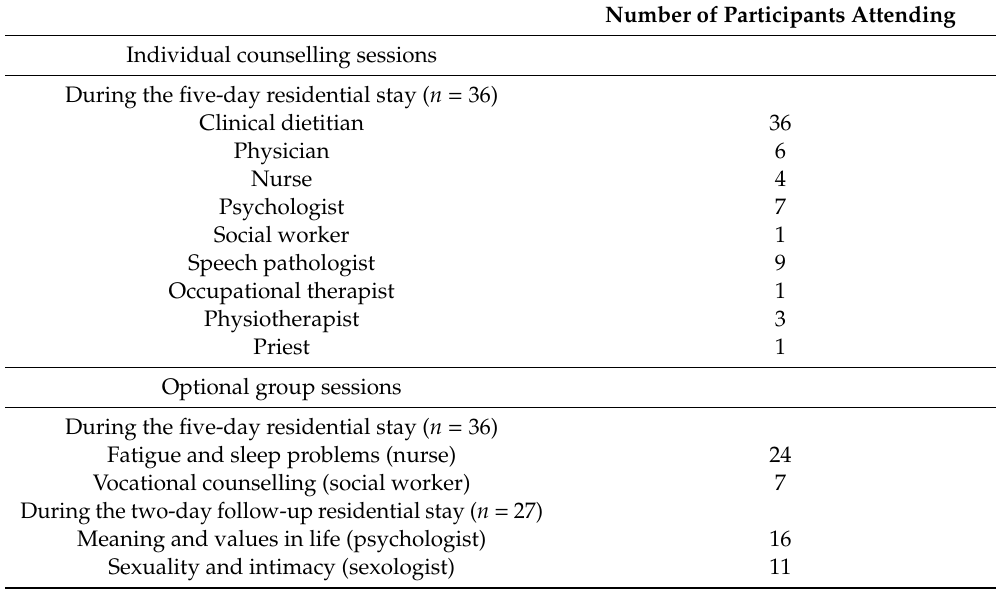
Table A1. Overview of scheduled individual counselling sessions and optional sessions attended by participants in the intervention group of the NUTRI-HAB